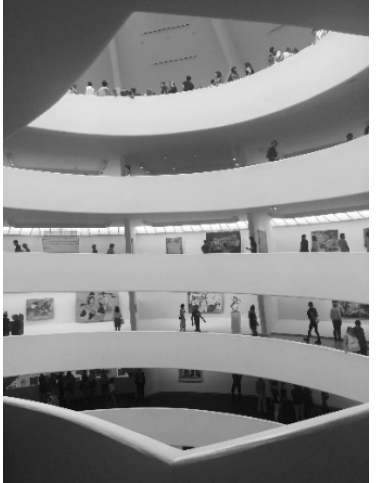
Figure 8. A view of the ramp and skylight at the Guggenheim New York.